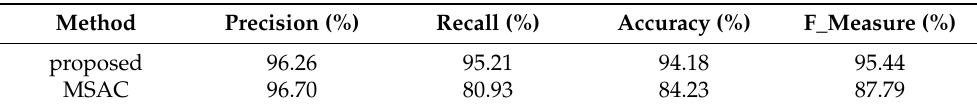
Table 4. Mean, median, and 95th percentile of the accuracy of the estimated center using the proposed and MSAC methods.